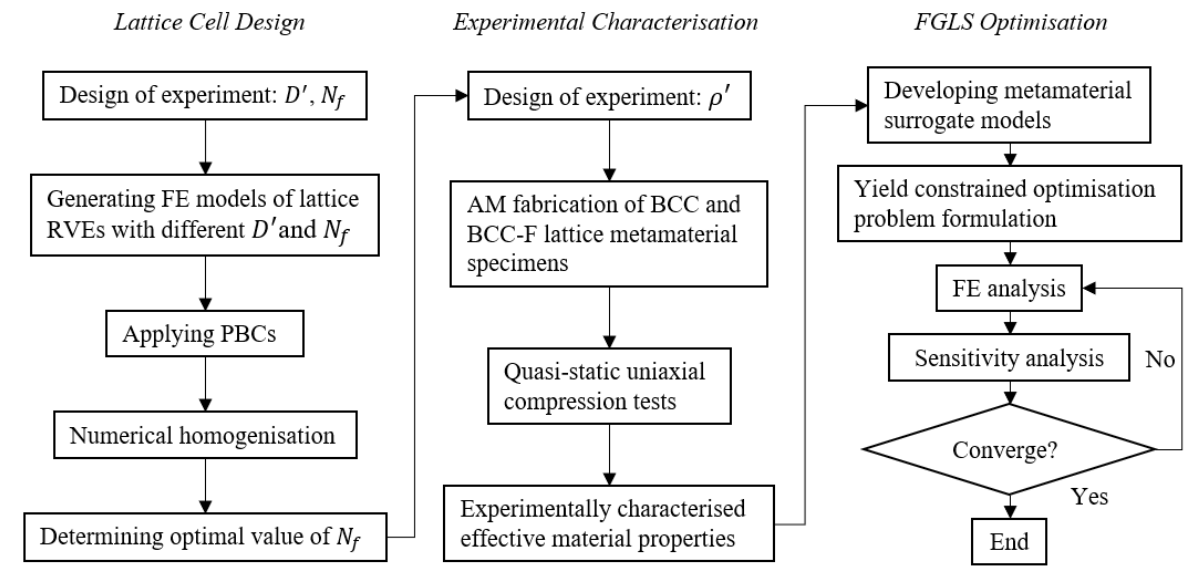
Figure 1. Flowchart of the yield constrained FGLS optimisation framework with experimentally characterised BCC and BCC-F lattice metamaterials. D (cid:48) and N f denote relative strut diameter and fillet parameter, respectively, which are defined in the next subsection (through Equations (1) and (2), respectively). FE, AM, RVE, PBC, FGLS denote finite element, additive manufacturing, representative volume element, periodic boundary condition, and functionally graded lattice structure, respectively.